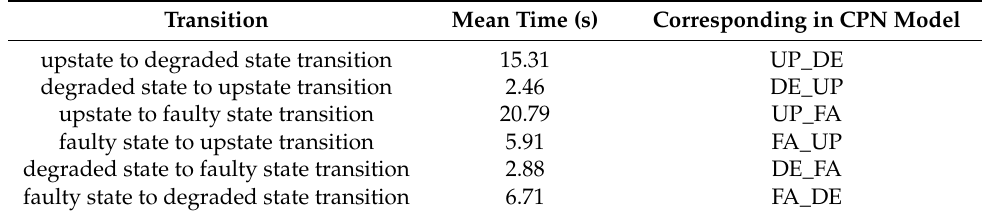
Table 5. Distribution of Each Transition and